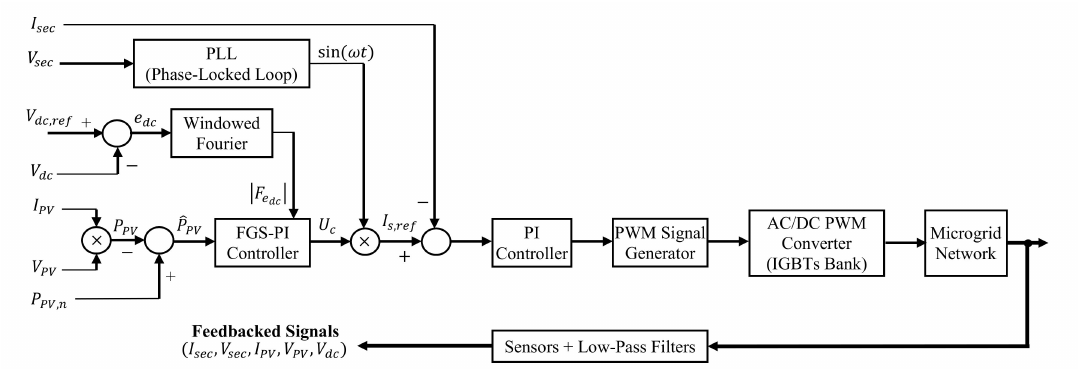
Figure 6. Passive fault-tolerant control (PFTC) loop of the AC / DC PWM converter based on Fourier analysis and FGS-PI